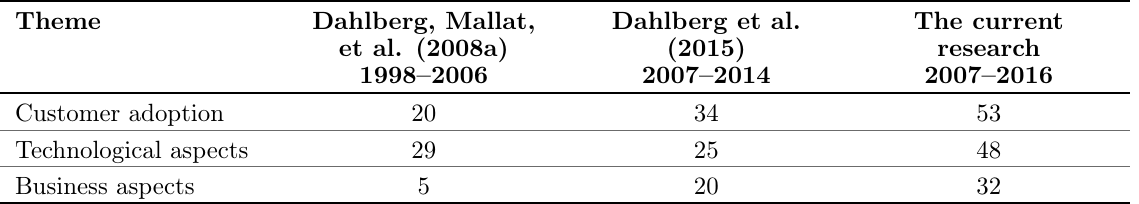
Table 20. Comparison of trends in number of papers within the main research